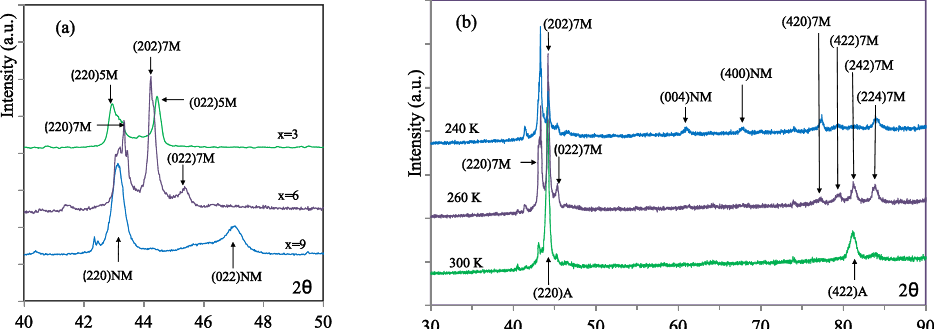
Figure 5. ( a ) Representative portion of the X-ray di ff raction (XRD) patterns of the martensite structures Table 3. Lattice parameters of the identified structures (in nm), tetragonality ( c / a ) computed middle for x = 3, x = 6, and x = 9; ( b ) XRD patterns obtained at di ff erent temperatures for x = 6, corresponding structures for x = 3, x = 6, and x = 9; ( b ) XRD patterns obtained at different temperatures for x = 6, eigenvalue (λ 2 ), and thermal hysteresis (K) for the different x values. corresponding to the structures of austenite, 7M, and NM martensites. to the structures of austenite, 7M, and NM martensites.